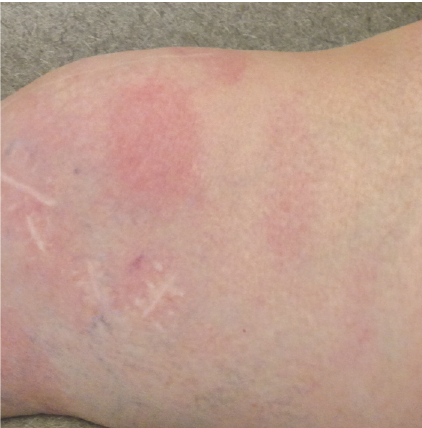
Figure 1: Macular rash over the right knee.